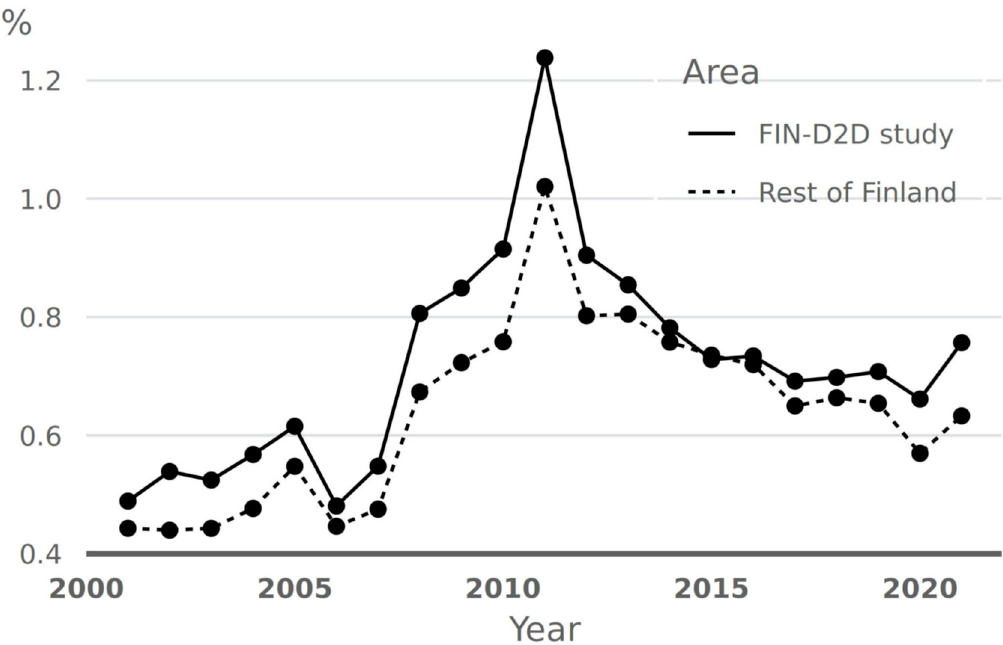
Figure 1. Age-standardized (The Finnish age distribution as standard) incidence of new reimbursement rights for glucose-lowering drug treatment by the Finnish Social Insurance Institution in the FIN-D2D study areas and the rest of Finland.